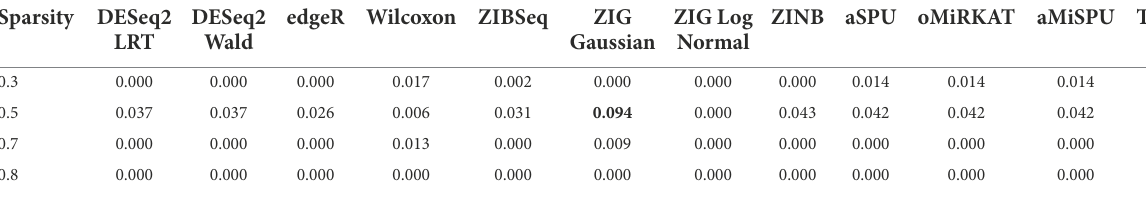
Bold value indicates to inflated type I errors.